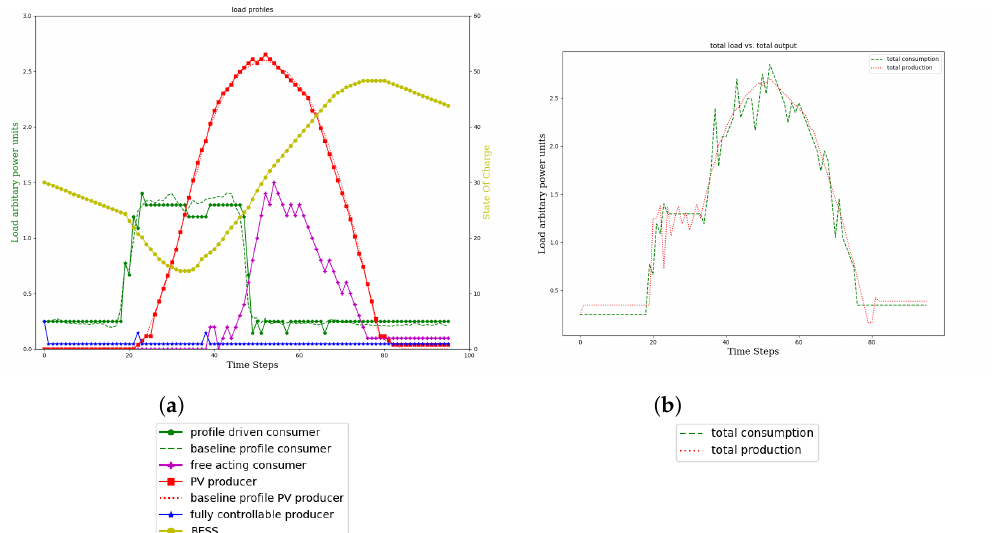
Figure 15. Evaluation on day 2, with the generalised trained agents. ( a ) Agent load curves and profiles. ( b ) Load balancing.